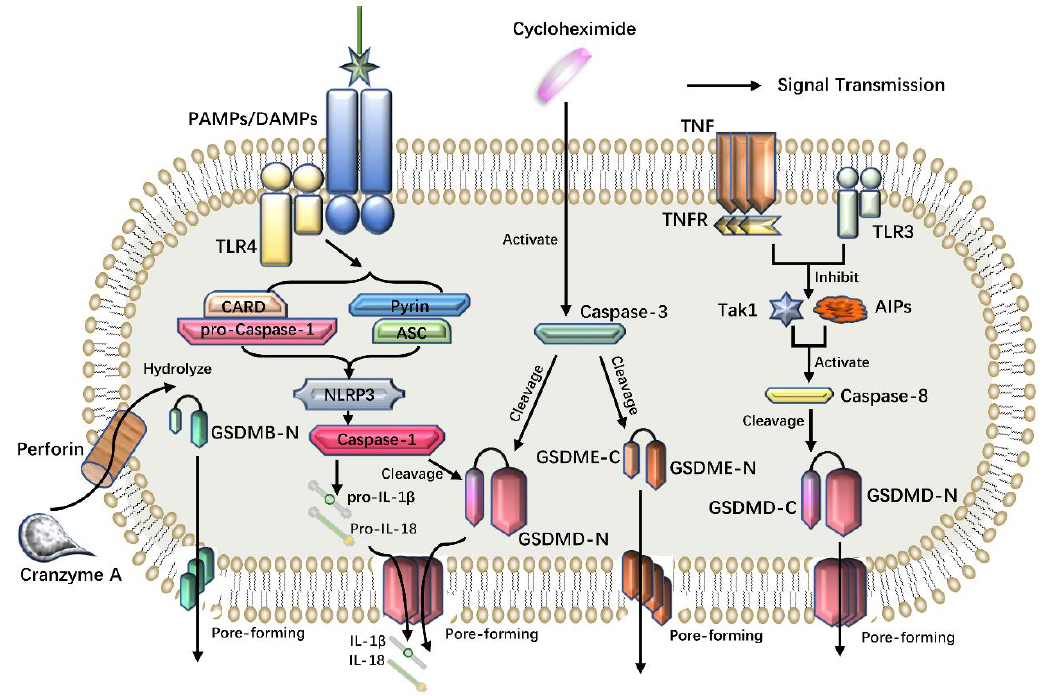
Figure 3. Other pyroptosis pathways. Chemotherapeutic drugs induce the activation of caspase-3, which can cleave GSDME. Once GSDME is cleaved, its N-terminal can also lead to perforation of the plasma membrane, release of inflammatory substances and mediate pyroptosis. In addition, TNF and TLR3 can inhibit AIPs and Tak1, which in turn activates caspase-8 to cleave GSDMD, resulting in pyroptosis. GZMA and GZMB in cytotoxic lymphocytes can enter target cells through perforin and induce pyroptosis by hydrolyzing GSDMB and GSDME,